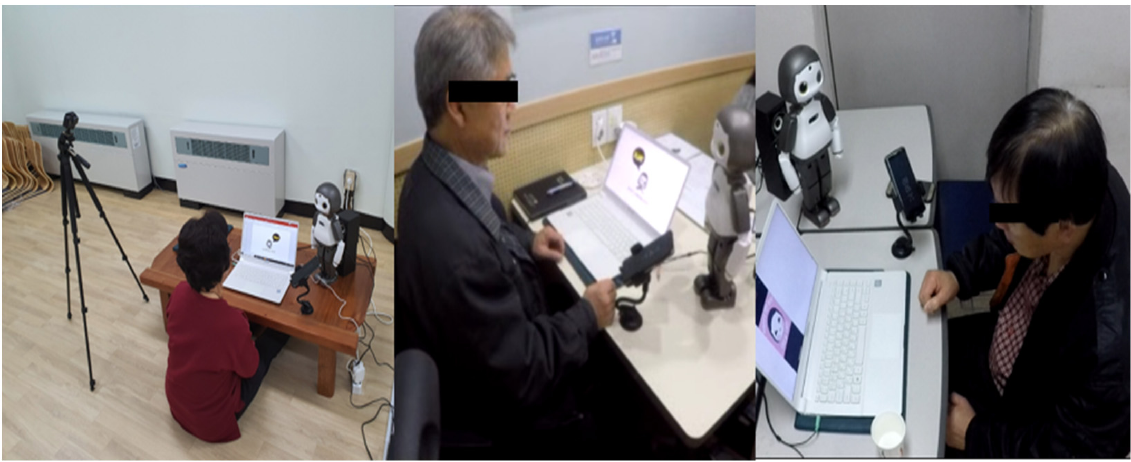
Figure 4. Experimental